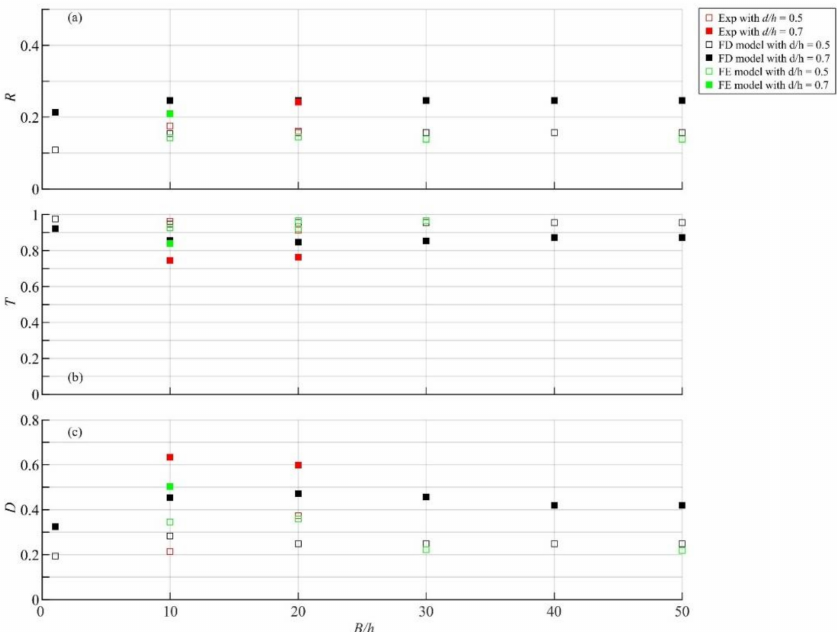
Figure 8. Relation of ( a ) reflection ( b ) transmission and ( c ) dissipation coefficient with the step width ratio ( B/h ) for the solitary wave over a submerged step with step heights d/h of 0.5 and 0.7 (red and filled squares denote experimental results with a d/h of 0.5 and 0.7; black and filled squares represent FD model results with a d/h of 0.5 and 0.7; green and filled squares denote FE model results with a d/h of 0.5 and 0.7, respectively).